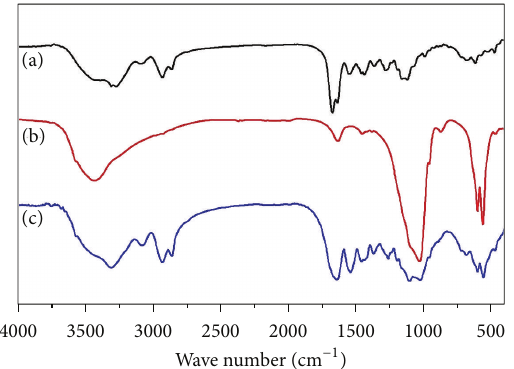
Figure1:FT-IRspectraofPA(a),s-HA(b),ands-HA/PAcomposite (c).